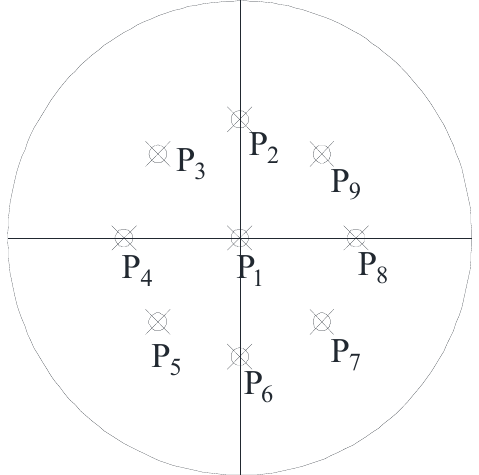
Figure 7. Location diagram of the outlet pipe monitoring curves.